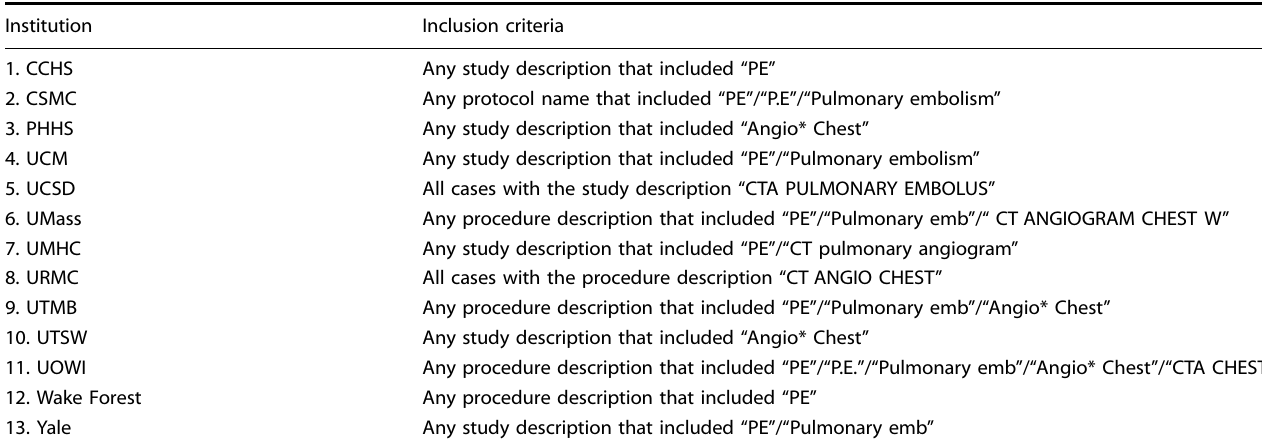
Table 4. Inclusion criteria for CTPA studies at each